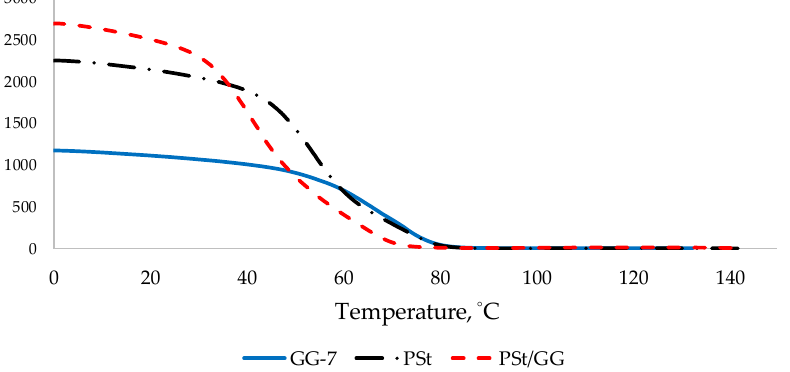
Figure 9. E’ of PSt -VBzGG-7 SIPN (GG-7, solid blue trace), PSt (black trace) and PSt/GG mixture (red dotted trace).